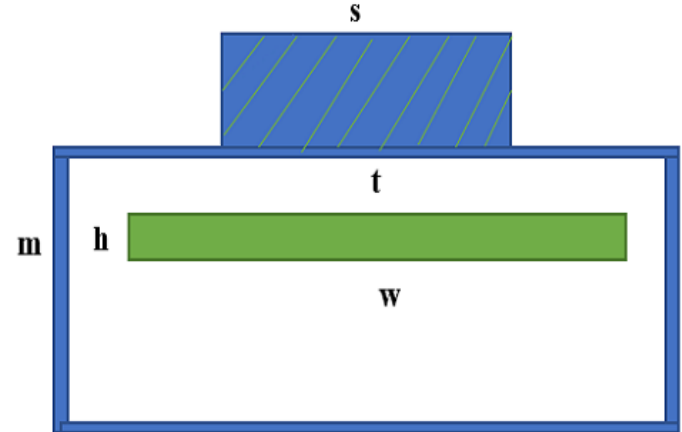
Figure 2. Cross-section view of the soft